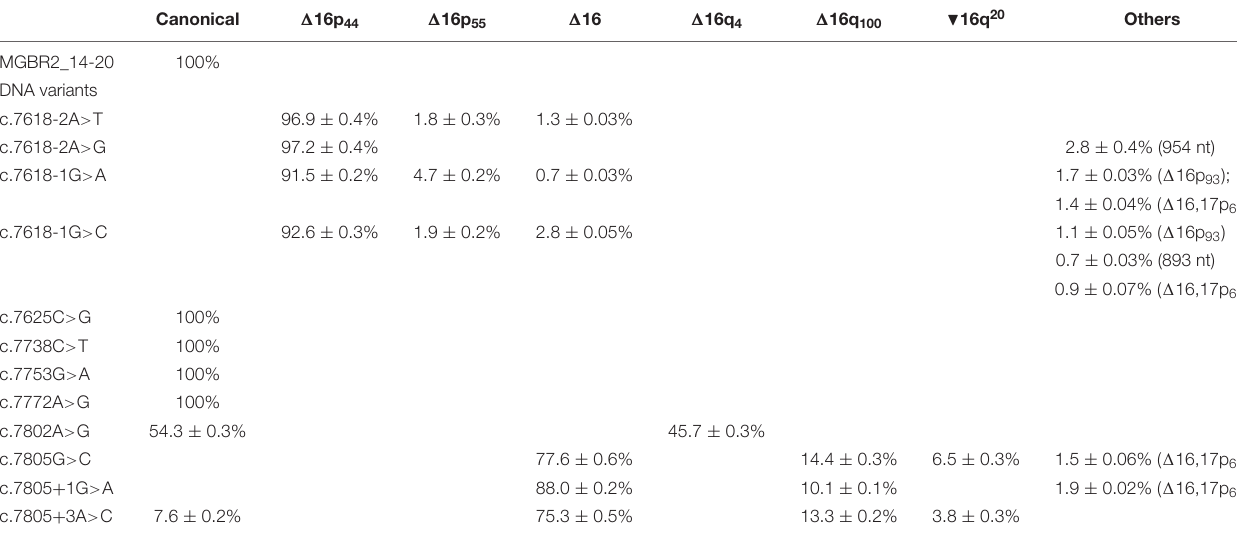
TABLE 3 | Quantification of transcripts of spliceogenic variants of exon 16 by fluorescent capillary electrophoresis.